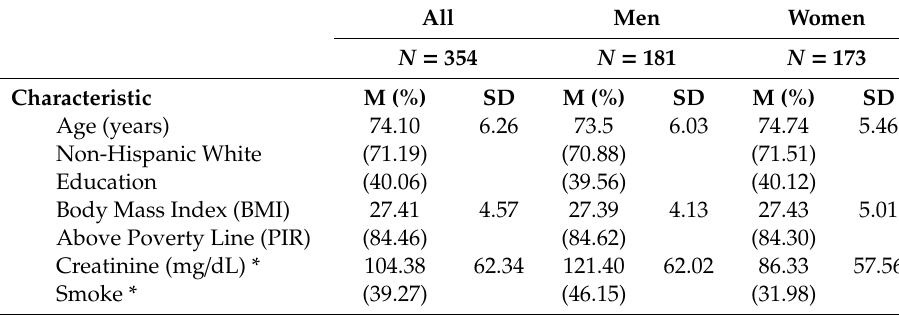
Table 1. Demographic